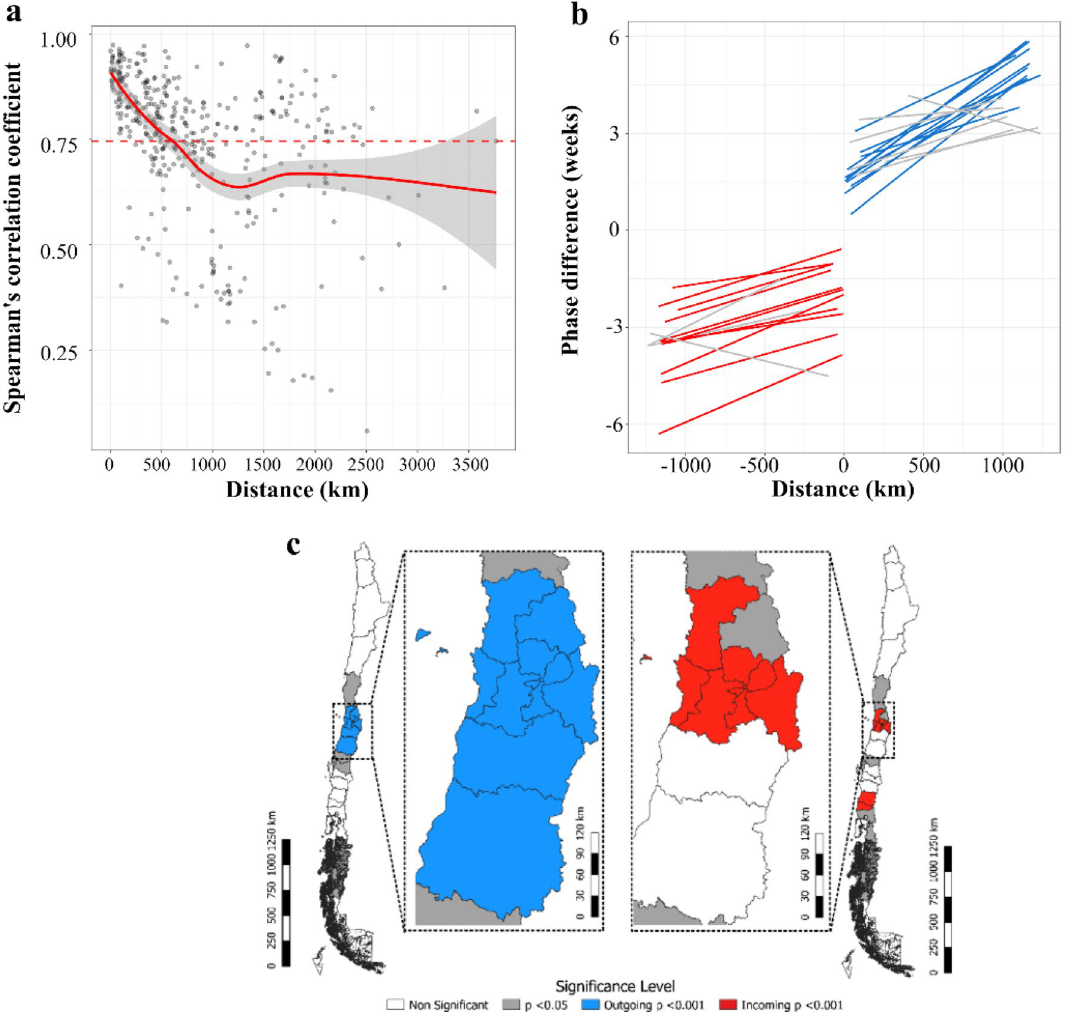
Figure 5. Distance vs pairwise Spearman’s correlation and travelling waves of influenza in health networks. Chile 2010–2016. ( a ) Spearman’s correlation of phase angles versus distance between all pairs of health networks. Dashed lines represent the average correlation. The model used a loess model with α = 0.75 (red line) and 95% CI (grey). There is a change in the descending relation of correlation and distance at 1250 km that we used as the upper distance limit to define local wave. ( b ) Phase difference in weeks vs distance (km) for Health Networks with incoming (red) and outgoing (blue) waves. In grey linear models with a significance level of 0.05. In red and blue, linear models with a Bonferroni corrected significance level < 0.001. The distance sign was inverted for negative lag times for a more intuitive display of incoming waves. ( c ) Geographic location of health networks with significant traveling waves. Incoming and outgoing waves are clustered in the center of the country. Colors correspond to panel ( b ) 24,27